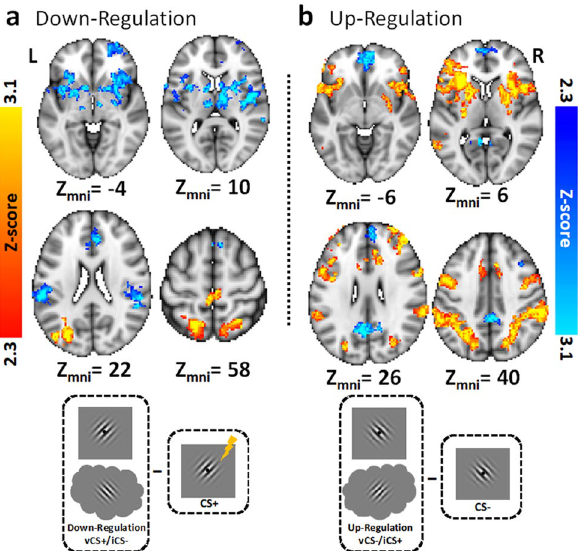
Figure 4. Results from the whole-brain analysis of the emotion regulation phase (experiment 2). ( a ) Results comparing the ‘down-regulate’ CS+ (red-yellow) condition to the ‘view’ CS+ (blue-light blue) condition. The ‘down-regulate’ CS+ had participants imagine the CS− while viewing the CS+. ( b ) Results comparing the ‘up-regulate’ CS− (red-yellow) condition to the ‘view’ CS− (blue-light blue) condition. The ‘up-regulate’ CS− had participants imagine the CS+ while viewing the CS−.